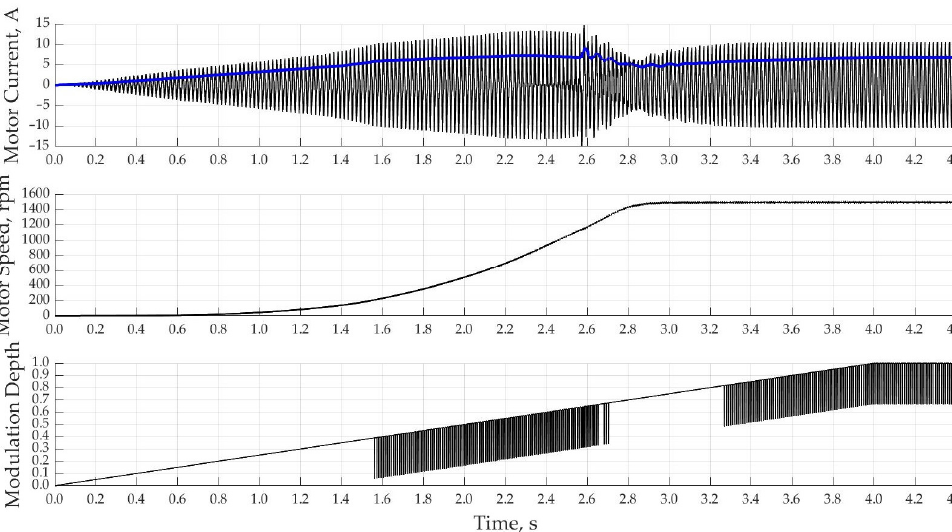
Figure 12. Starting current, motor speed and modulation depth under relay controller with the last zone disabled.